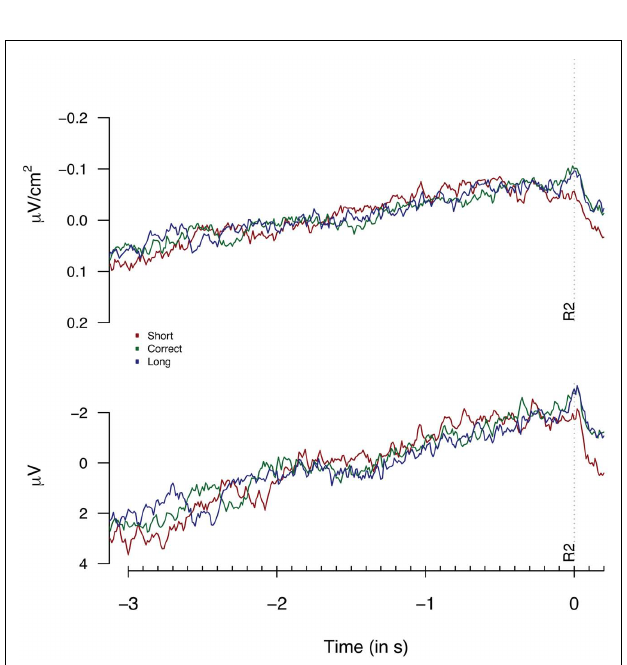
FIGURE 3 | Laplacians (top graph) and monopolar recordings (bottom graph) obtained at FCz during Experiment 1 as a function of participants’ behavioral performance, plotted time-locked to the second key press (R2). Laplacians are based on 9 “3-in-a-row” participants, monopolar data are based on the extended dataset consisting of 17